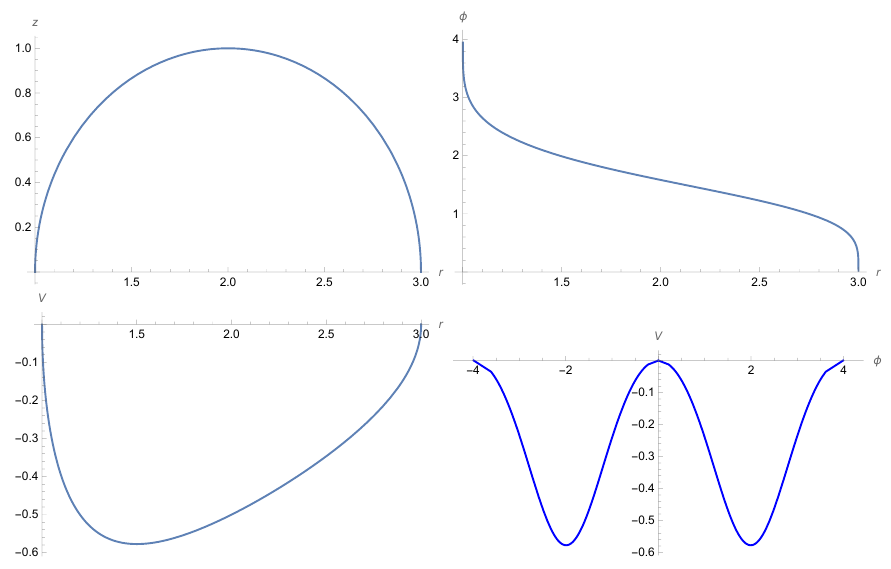
Figure 15 . Configurations of half of a torus. The quadratic coefficient is -0.25 for both